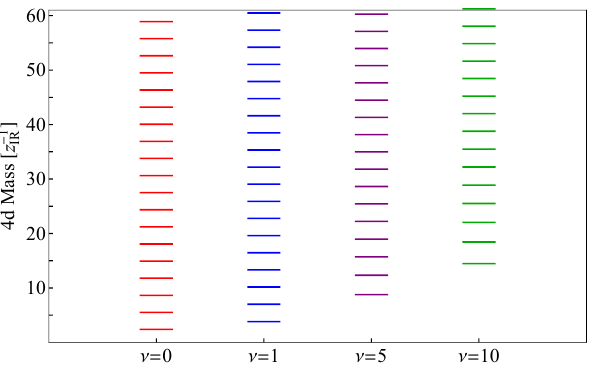
Figure 2 . The mass spectra of KK towers for ν = 0 , 1 , 5 , and 10 respectively, in units of 1 /z starting at the lowest mode. We assume Dirichlet boundary conditions on the IR brane. We IR highlight two important trends. First, the lowest mass in the tower increases as ν increases. Second, the mass splittings sufficiently high in each tower are approximately equal and independent of ν